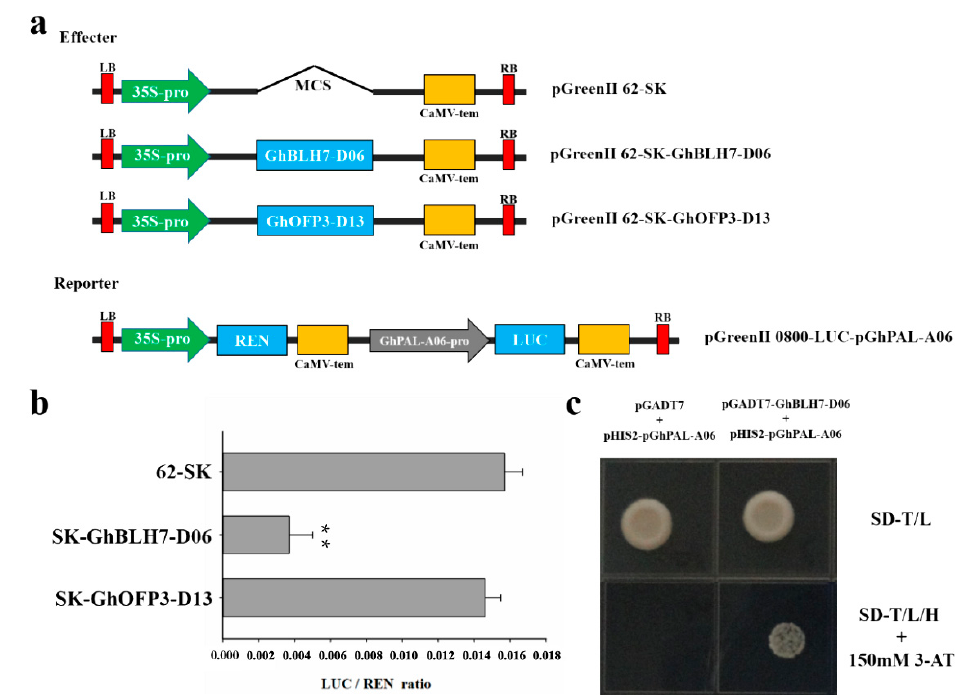
Figure 6. Validation the targeting regulation of GhBLH7-D06 on GhPAL-A06 : ( a,b ) the targeting regulation of GhBLH7-D06 and GhOFP3-D13 on GhPAL-A06 by dual-luciferase reporter assay system; and ( c ) validation of interaction between GhBLH7-D06 and GhPAL-A06 promoter by Y1H. The empty vector control group (pHIS2-pGhPAL-A06 + pGADT7) and the experimental group (pHIS2-pGhPAL-A06 + pGADT7-GhBLH7-D06) were grown on two-deficient medium SD-T/L (SD- Trp/-Leu) and three-deficient medium SD-T/L/H + 150 mM 3-AT (SD-Trp/-Leu/-His + 150 mM 3-AT). Error bars represent the standard deviation of three biological replicates. Asterisks indicate statistically significant differences, as determined by Student’s t -test (** p <